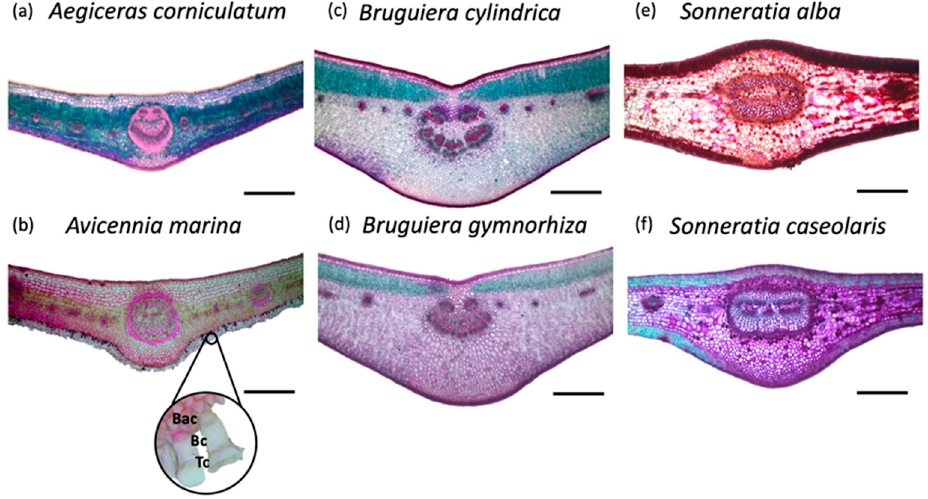
Figure 3. ( a – f ) Transverse microtome cross-sections through the midvein and adjacent lamina tissue of six different mangrove species’ leaves stained with safranin O–fast green. ( b ) Inset: awl-shaped trichomes at the abaxial leaf area. Scale bars = 500 µ m. Abbreviations: Bac = Basal cell, Bc = Body cell and Tc = Top cell.